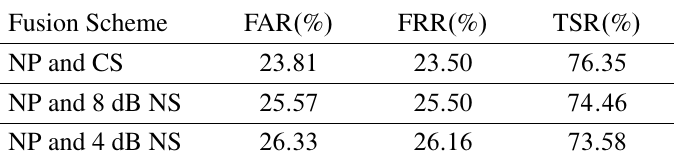
Table 7. Verification rate of match score level fusion of noisy palmprint using PCA MM with speech (clean and noisy).